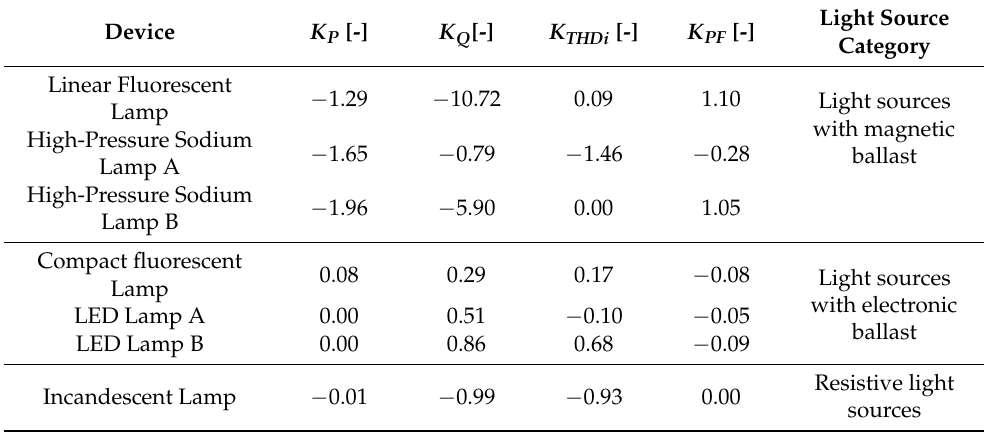
Figure 8. Analyzed load static characteristics of air conditioner ( a ) K P , K fP ; ( b ) K Q , K fQ .